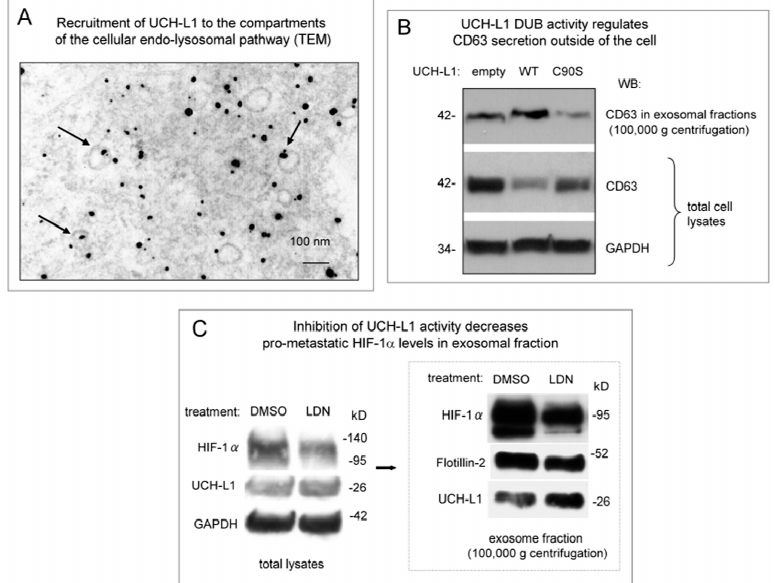
Figure 1. Ubiquitin carboxyl-terminal hydrolase L1 (UCH-L1) de-ubiquitinating activity is involved in regulation of membrane tra ffi cking pathways. ( A ) UCH-L1 is physically associated with the vesicles of the cellular endolysosomal pathway. Electron microscopy of 293 cells immune gold-labeled for UCH-L1 (10 nm gold particles, black dots). Two hundred and ninety-three cells transfected with UCH-L1 expression vector were subjected to ultrastructural examination. Fixed ultra-sections were stained with UCH-L1 primary and colloidal gold-labeled secondary antibodies. Arrows show the intra-cellular compartments of the endo-lysosomal pathway. ( B ) UCH-L1 de-ubiquitinating (DUB) activity is involved in regulation of CD63 secretion in exosomes. Two hundred and ninety-three cells were transfected with WT and C90S UCH-L1 expression vectors. After 48 h of incubation, exosomes were purified by sequential ultracentrifugation as described in Materials and Methods section. Western blot analysis demonstrates that CD63 levels in the exosome fraction were reduced when the cells were transfected with DUB-dead UCH-L1 mutant compared to WT-expressing control. Western blot for CD63 in total lysates of the same cells confirms the results in exosomal fractions showing reverse correlation in CD63 levels between WT- and C90S-expressing cells (normalization to GAPDH). ( C ) Inhibition of UCH-L1 DUB activity with the selective small-molecule inhibitor LDN-57444 decreases the levels pro-metastaticHIF-1 α in exosomal fractions. After transfection with hypoxia-inducible factor 1 α (HIF-1 α expression vector 293 cells were treated with three µ M of LDN-57444 or DMSO as a control. After 48 h exosome fractions were purified by ultracentrifugation as described in Materials and Methods. The results of Western blot analysis of total cellular lysates and exosomal fractions show that HIF-1 α levels in the exosomal fraction were reduced when UCH-L1 DUB activity was inhibited. Protein levels in the exosomal fractions were normalized on UCH-L1 levels and on the exosome marker Flotillin-2. GAPDH served as normalization control for total